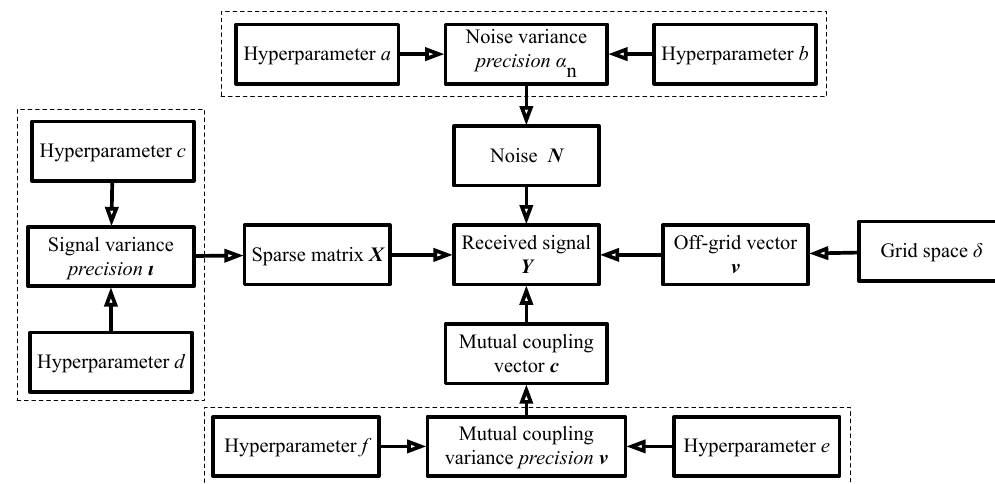
Figure 4. Graphical model of sparse bayesian learning for direction